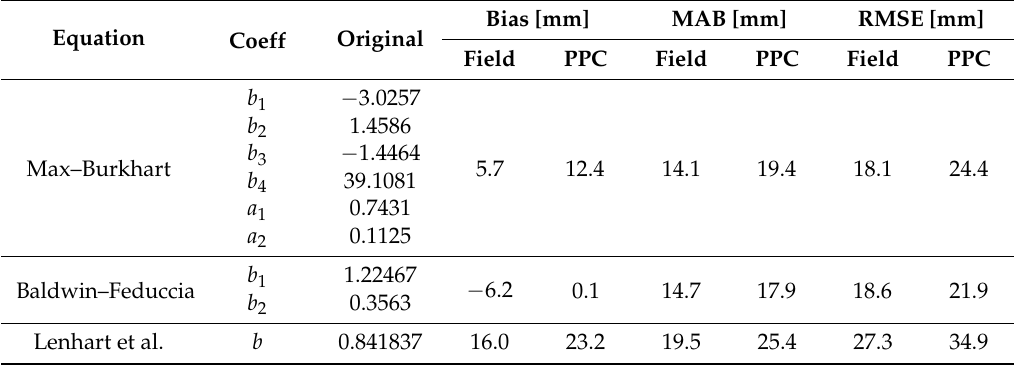
Table 4. Performance of existing taper models on field and PPC-based measurements. Max–Burkhart Model 4 was used for assessment. MAB, mean absolute